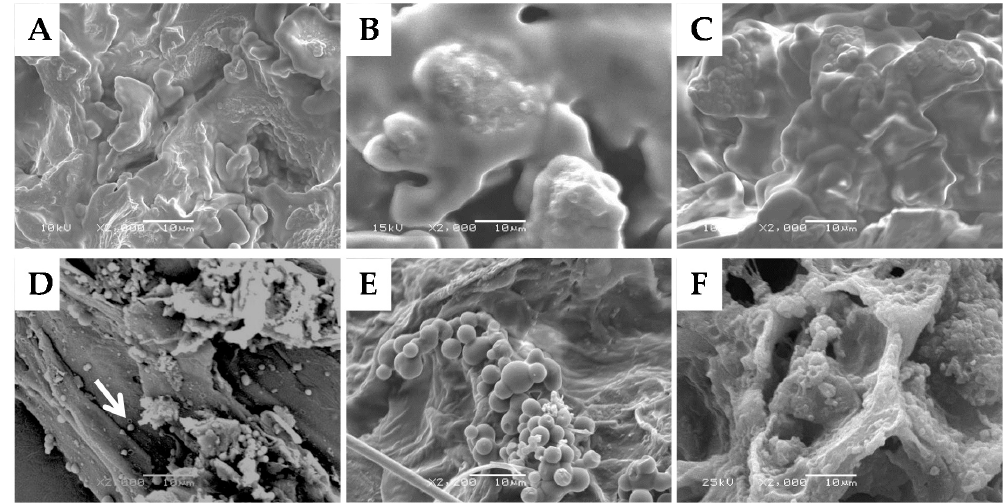
Figure 1. SEM images of ( A ) dried coffee particle; ( B ) dried and ball milled coffee particle and ( C – F ) following hydrothermal treatment at ( C ) 150 °C; ( D ) 200 °C; ( E ) 250 °C; and ( F ) 275 °C for 1 h. Scale bar represents 10 μ m.